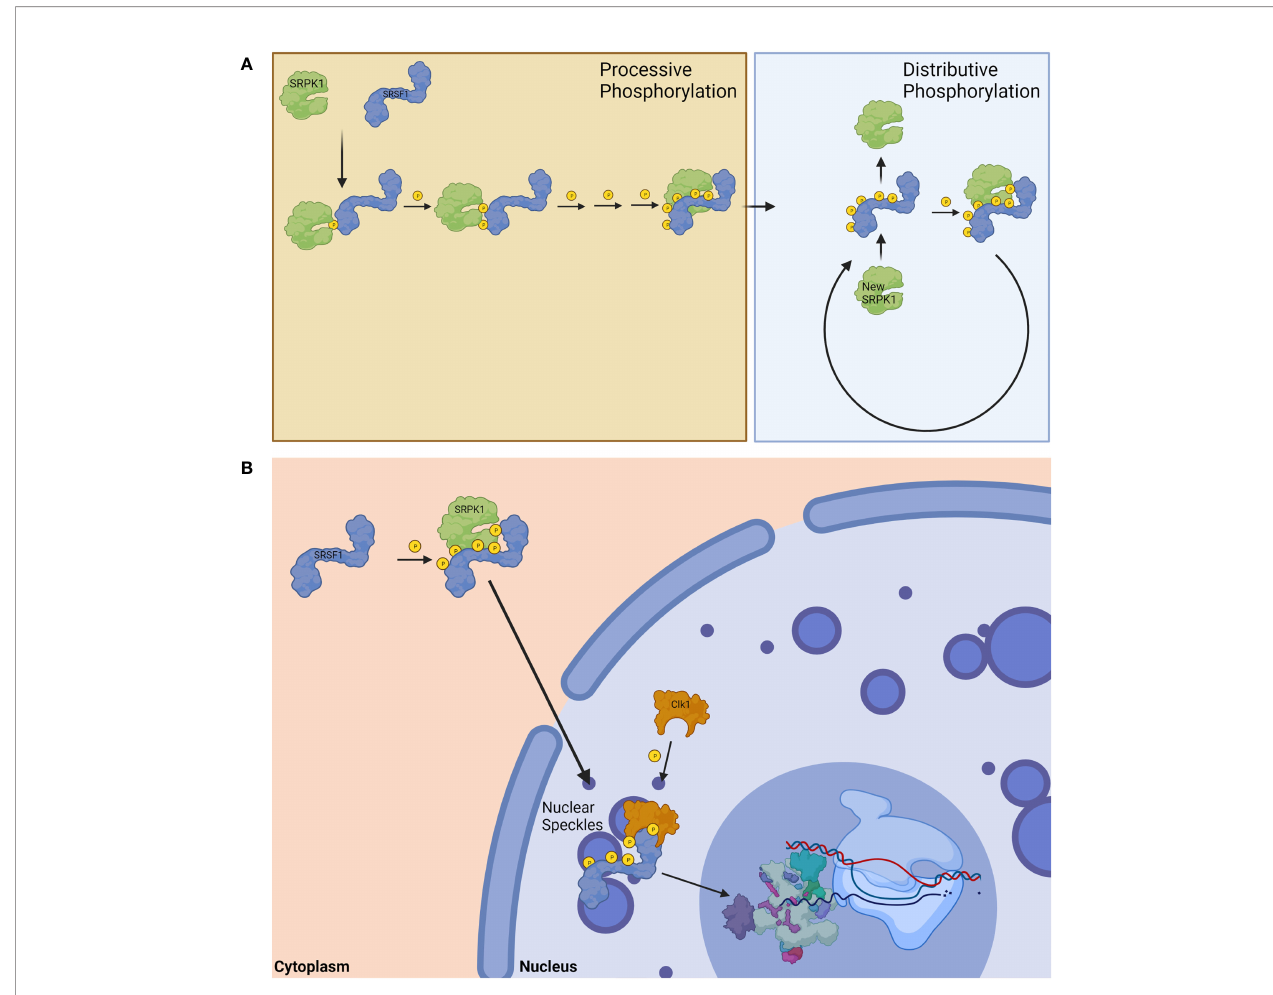
FIGURE 3 | Phosphorylation of SRSF1. (A) SRPK1 phosphorylates SRSF1 in a processive fashion until exhausted before switching to distributive phosphorylation. (B) The phosphorylation of SRSF1 allows for its translocation from the cytoplasm to the nucleus. Hypophosphorylated nuclear SRSF1 are localized in nuclear speckles until Clk1 phosphorylation releases them for spliceosomal function. Created with